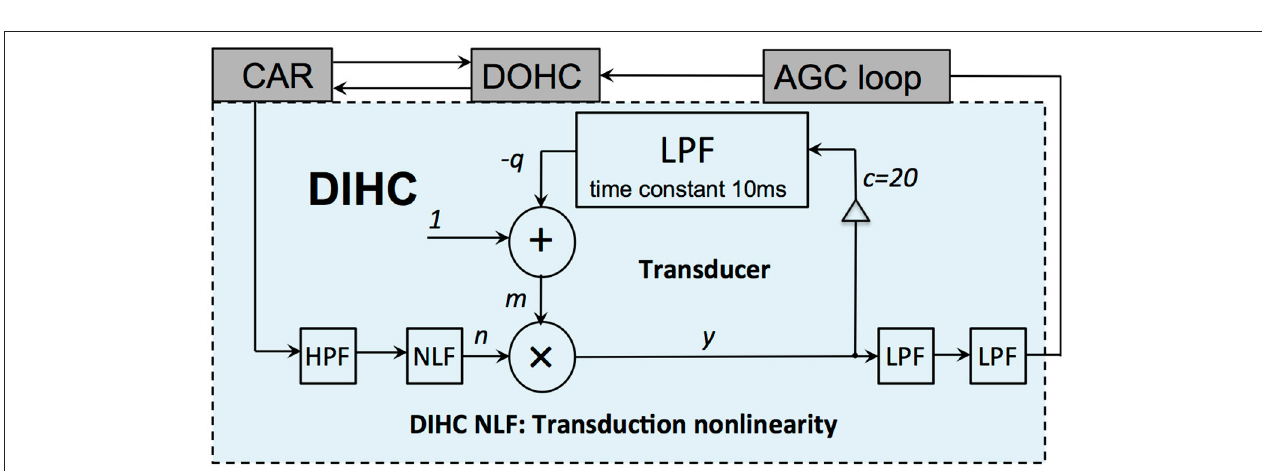
FIGURE 5 | Structure of the DIHC model. It comprises a HPF, a transduction nonlinearity unit, a transducer unit and two LPFs.